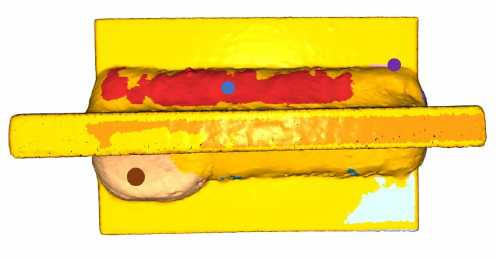
Figure 7. Excessive convexity defect with centers of the mass from the top view. The index of red is outside of the tolerance (3 mm) category B